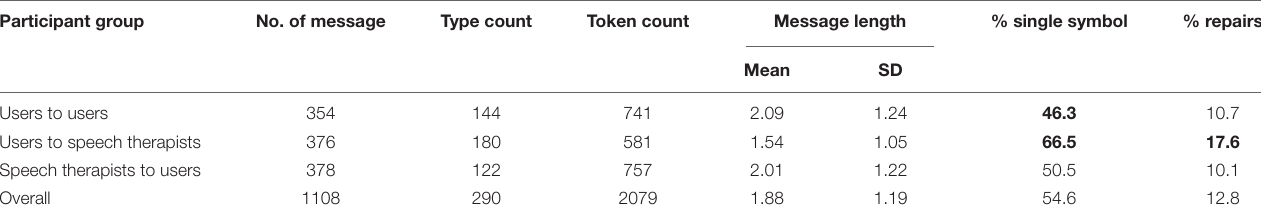
TABLE 2 | Message characteristics by participant